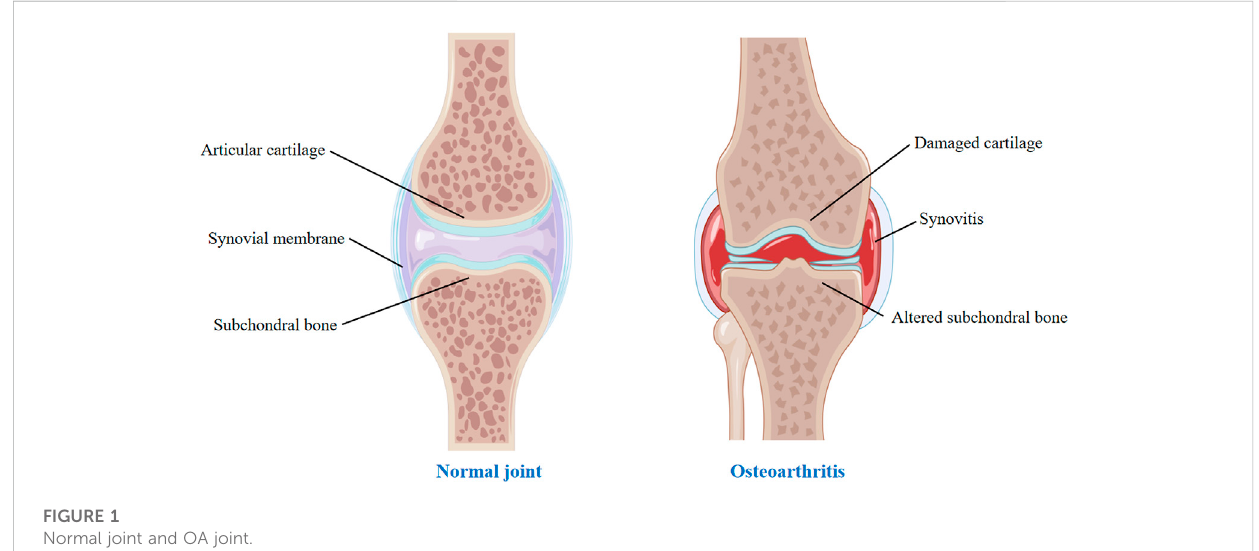
FIGURE 1 Normal joint and OA joint.